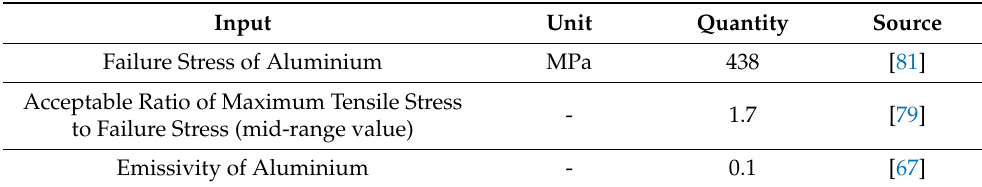
Table A4. Inputs for vacuum casing calculations [67,79,81].